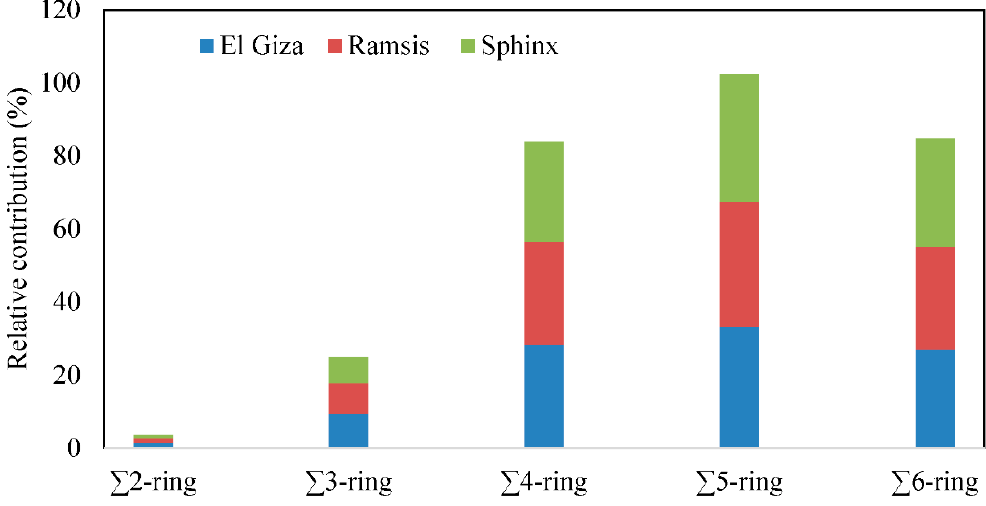
Figure 6. Relative contribution of the different categories of PAH based on aromatic ring number to the total concentrations of the PAH compounds in total suspended particulate at El Giza, Ramsis, and Sphinx Square.